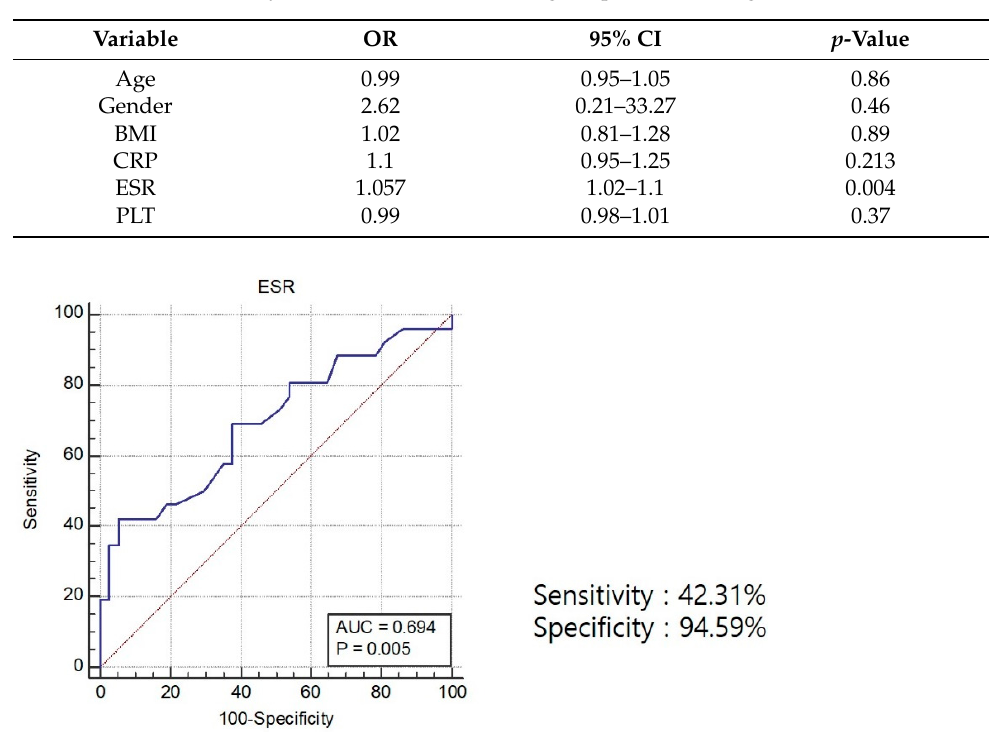
Table 4. Multivariate analysis of the factors influencing the positive findings of VCE.